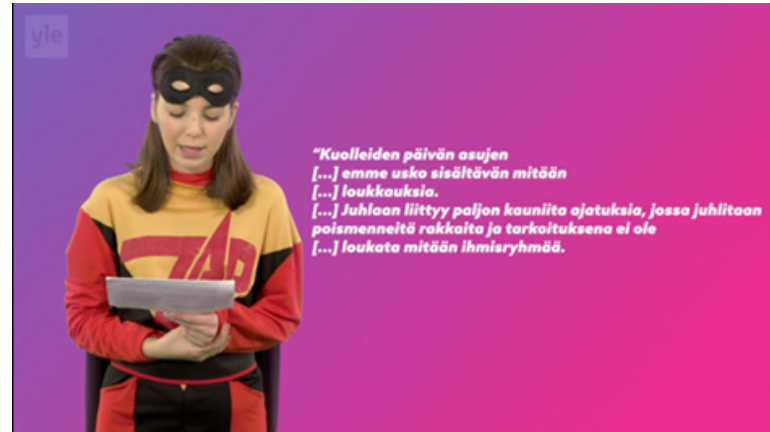
Figure 2. The suddenness of the teachable moment on diversity ( Yle Mix , 30 October 2020, 8.09 min). Media and Communication, 2022, Volume 10, Issue 4, Pages